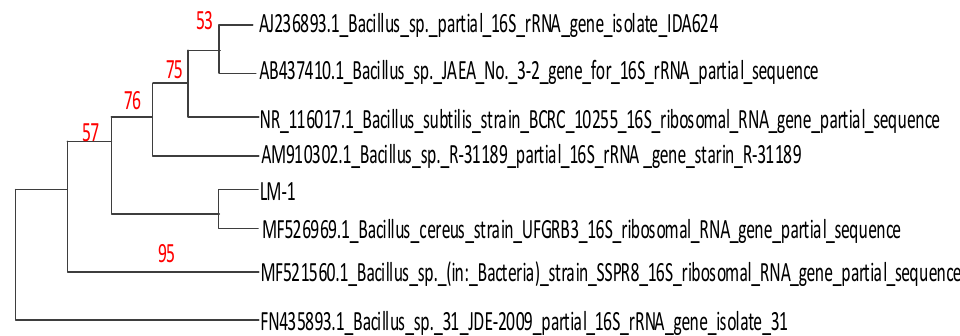
Figure 4. Phylogenetic analysis of isolated strain LM-1 in the neighbor-joining tree.